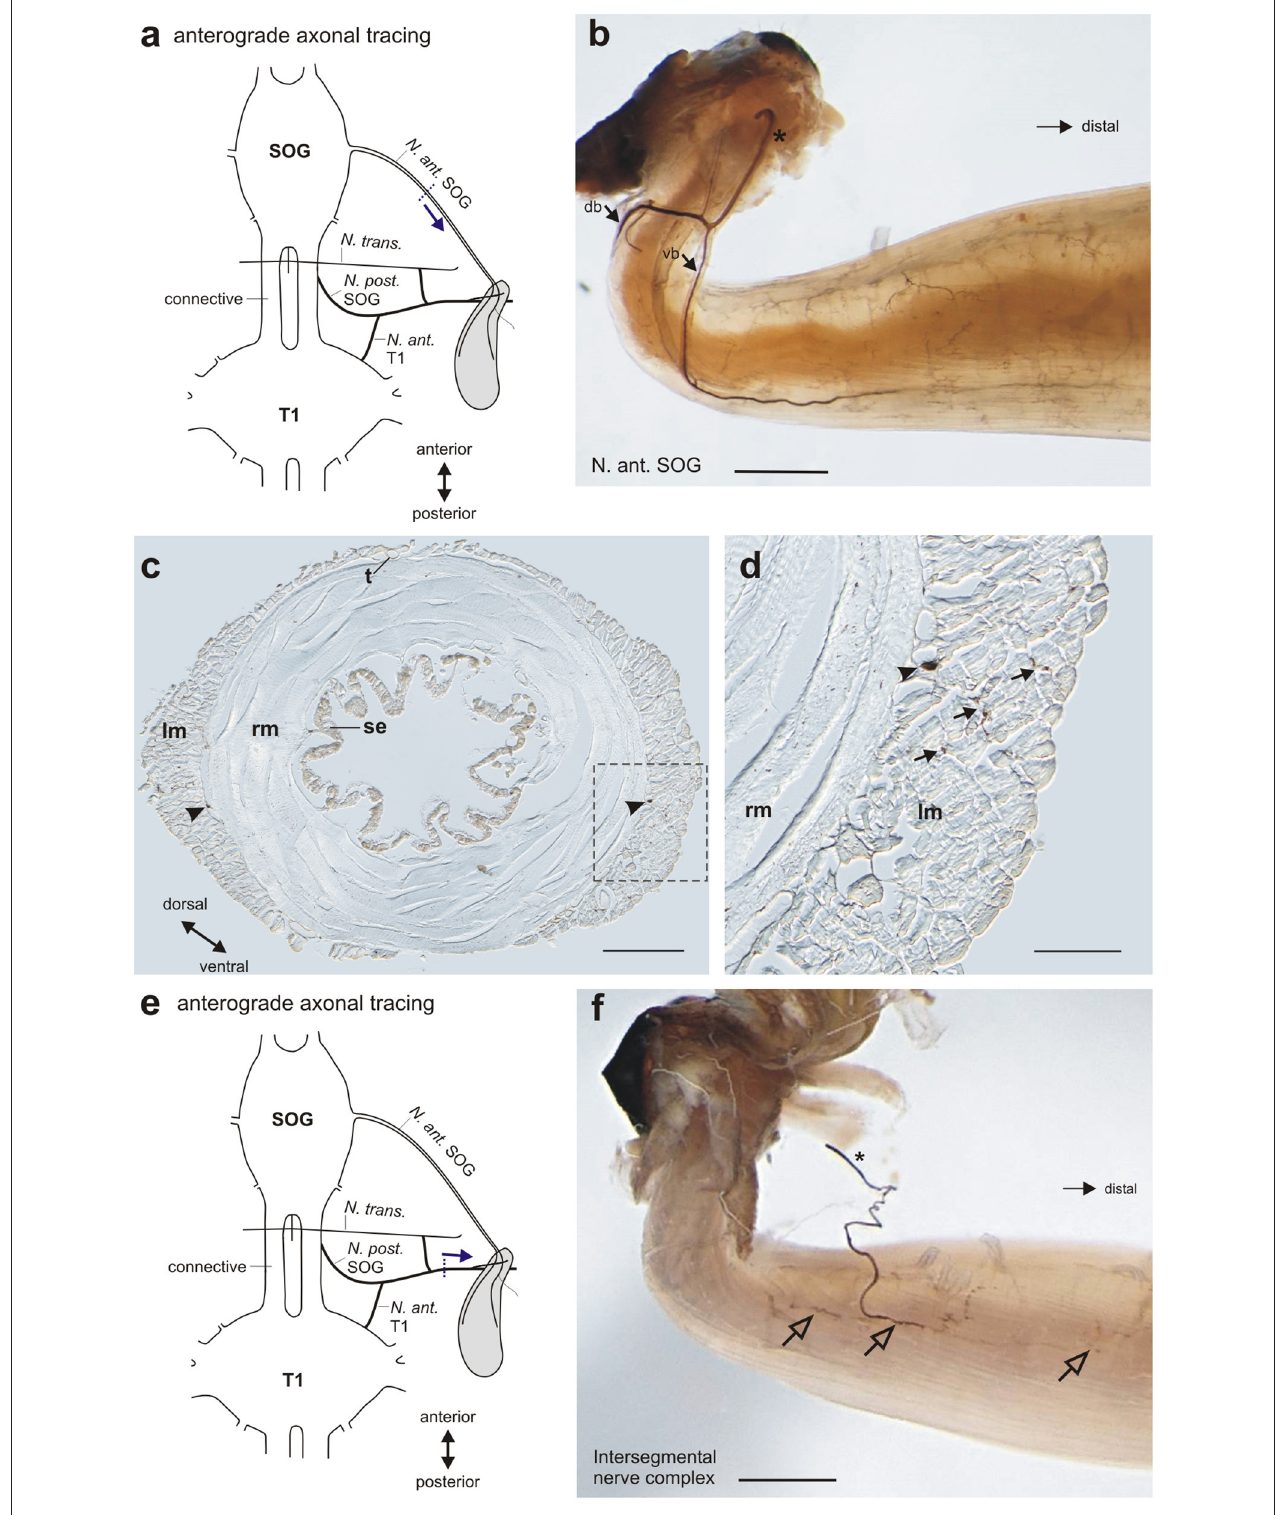
FIGURE 6 | Neural innervation of the defense gland shown by axonal tracing. (a) Schematic for the anterograde tracing of N. ant. SOG toward the defense gland. Dotted line indicates cut site of the nerve, arrow indicates the direction of axonal tracing. (b) Staining of nerve branches (dorsal branch db, ventral branch vb) and